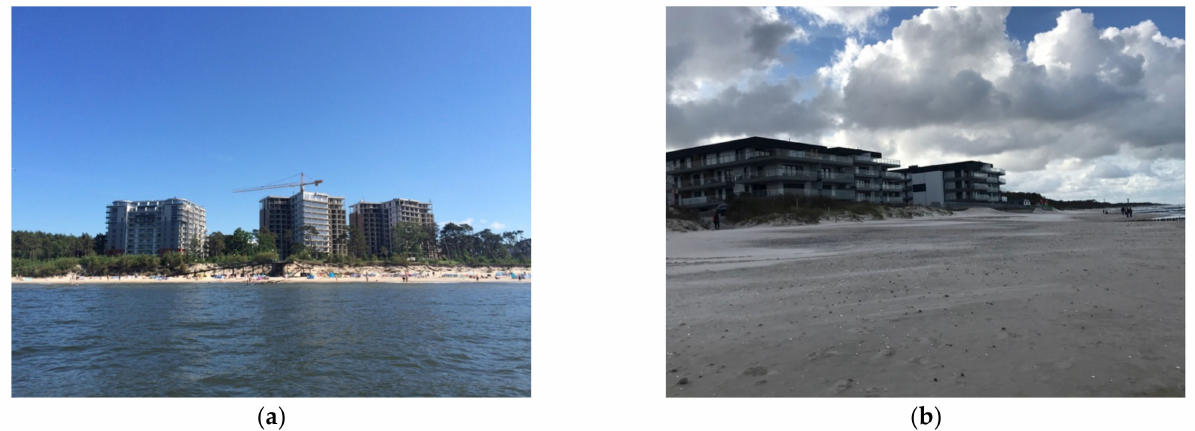
Figure 7. New buildings closer to the beach: ( a ) Dziwn ó wek. Porta Mare—extension and superstructure of the center from 1976–1983. ( b ) Dziwn ó w. Gardenia Seaside Apartments. Source: Author’s photo ( a [1], b ).